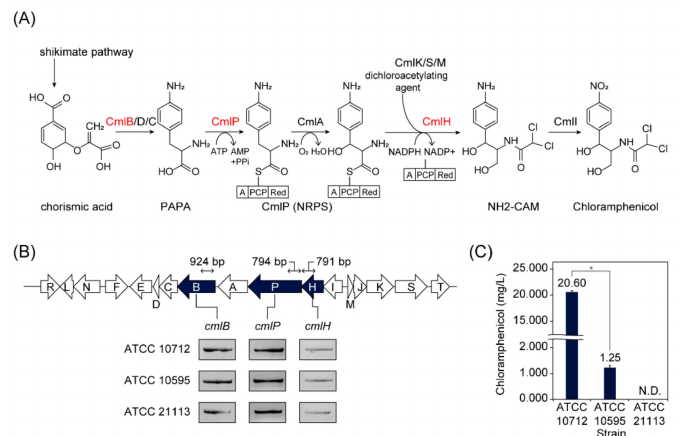
Figure 1. Screening S. venezuelae strains harboring chloramphenicol biosynthetic gene cluster (BGC). ( A ) Biosynthetic pathway of chloramphenicol. The three selected genes for PCR are colored as red.